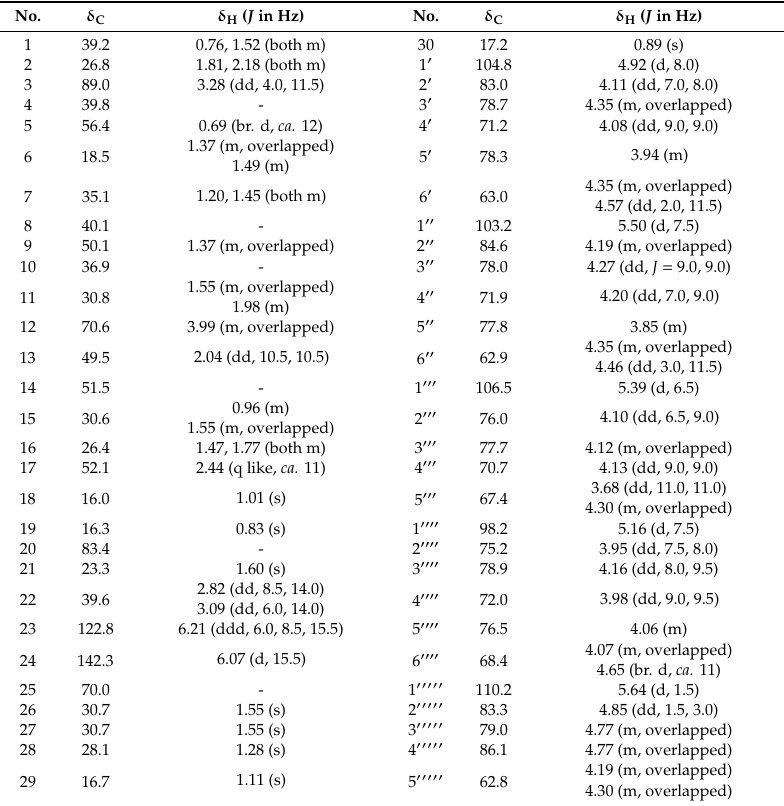
Table 6. The 1 H and 13 C-NMR data for 6 in C 5 D 5